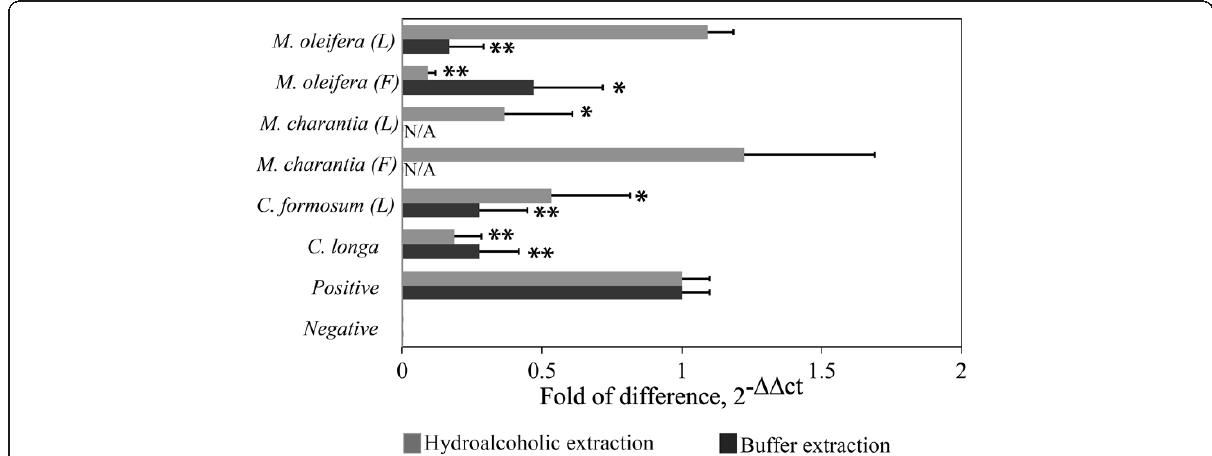
Figure 3 Effects of crude extracts on the level of cccDNA in transiently transfected HepG2 cells with the DNA expression plasmid of HBV genome. HepG2 cells were treated with either 30 μ g/mL of hydroalcoholic extracts or 0.3 μ g of buffer extracts and were transfected